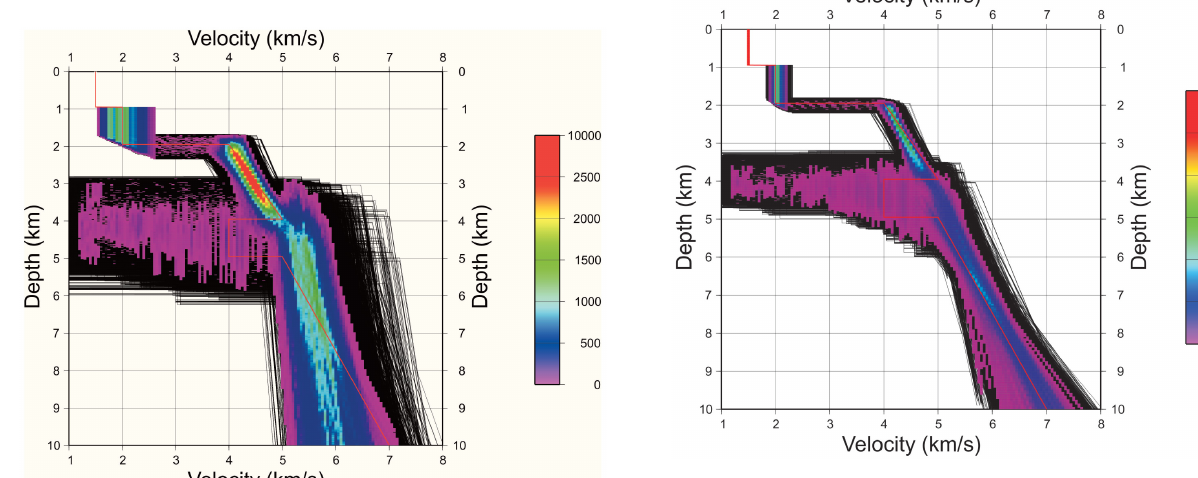
Fig. 18. Results obtained after using the Metropolis algorithm on data from model 2 and 20Hz for 40000 cases. Red line represents the real model and every black line a modified model. The colour scale stands for the number of times that a model (or part of it) is visited. The preferred model consists in a velocity gradient which includes basalt, sub-basalt and basement layers, avoiding the need of a low velocity layer under the